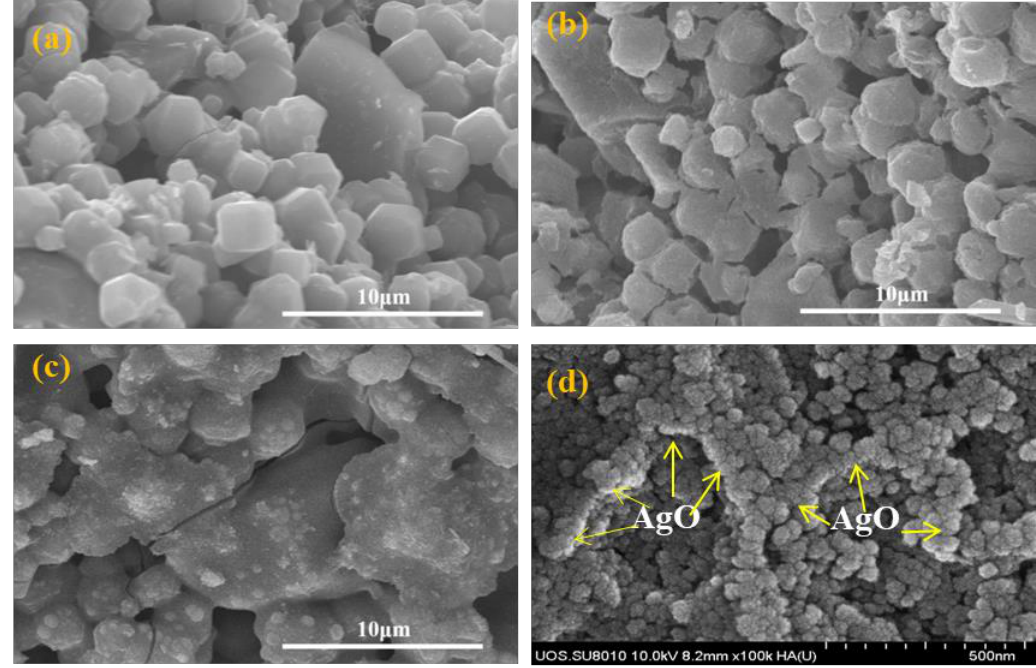
Figure 2. SEM images of phosphor beads ( a ) Sr 4 Al 14 O 25 :Eu 2+ ,Dy 3+ , ( b ) TiO 2 /Sr 4 Al 14 O 25 :Eu 2+ ,Dy 3+ , ( c ) Ag-TiO 2 /Sr 4 Al 14 O 25 :Eu 2+ ,Dy 3+ , and ( d ) AgO on TiO 2 /Sr 4 Al 14 O 25 :Eu 2+ ,Dy 3+ .